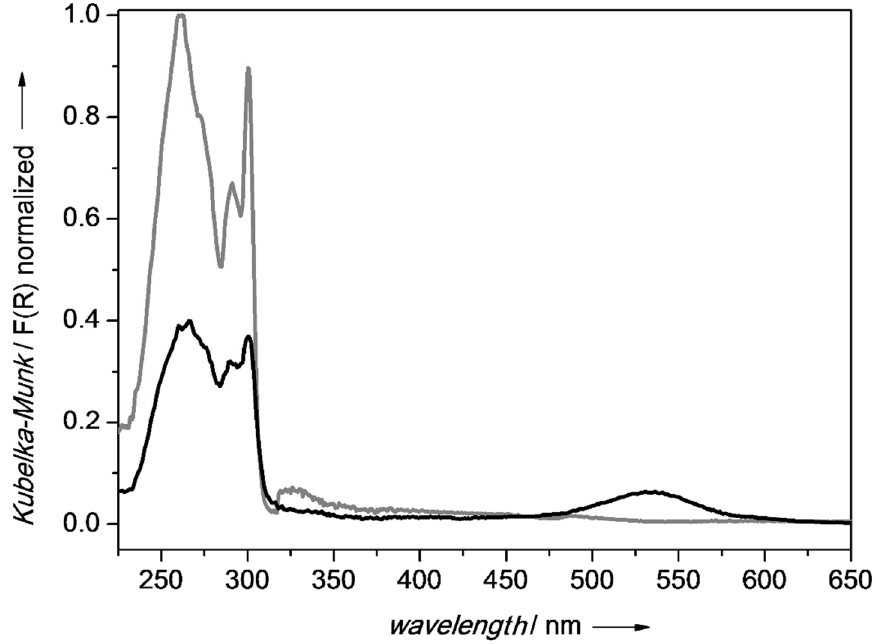
Figure 4. DR-UV/Vis spectra of CTA_FL_SAP_OP (black line) and CTA_FL_SAP_LAG (grey line) recorded from 200–800 nm.